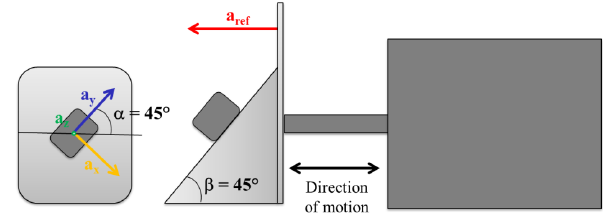
Figure 2. Scheme of the accelerometer installation.